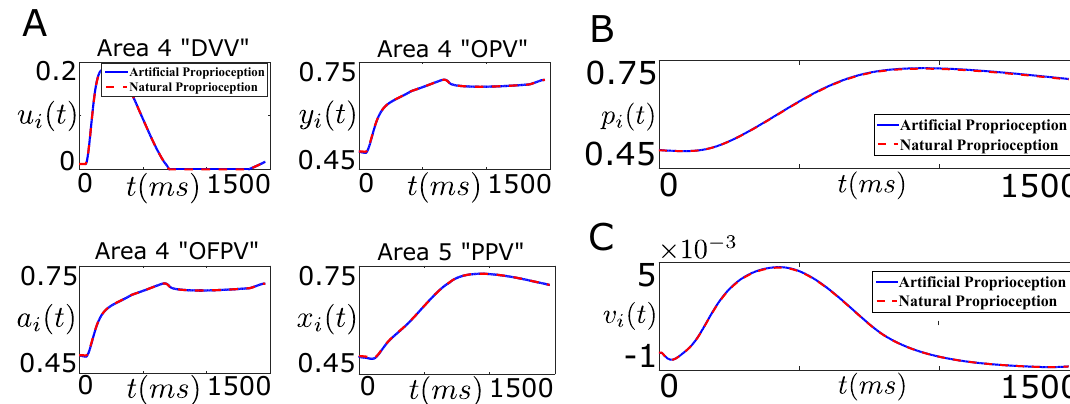
Figure 11. Performance of the designed closed-loop BMI in tracking the desired firing rate trajectory (“Problem 2”, Figure 9B). ( A ) shows the average firing activity of the cortical area 4 “DVV” neurons ( u i ( t ) ), “OPV” neurons ( y i ( t ) ), “OFPV” neurons ( a i ( t ) ), and the cortical area 5 “PPV” neurons ( x i ( t ) ) in the presence of artificial sensory feedback (solid line, blue) and the natural sensory feedback (dotted line, red); ( B ) shows the position trajectory of the agonist muscle i ( p i ( t ) ) in the presence of artificial sensory feedback (solid line, blue) and the natural sensory feedback (dotted line, red); ( C ) shows the velocity trajectory of the agonist muscle i ( v i ( t ) ) in the presence of artificial sensory feedback (solid line, blue) and the natural sensory feedback (dotted line, red).